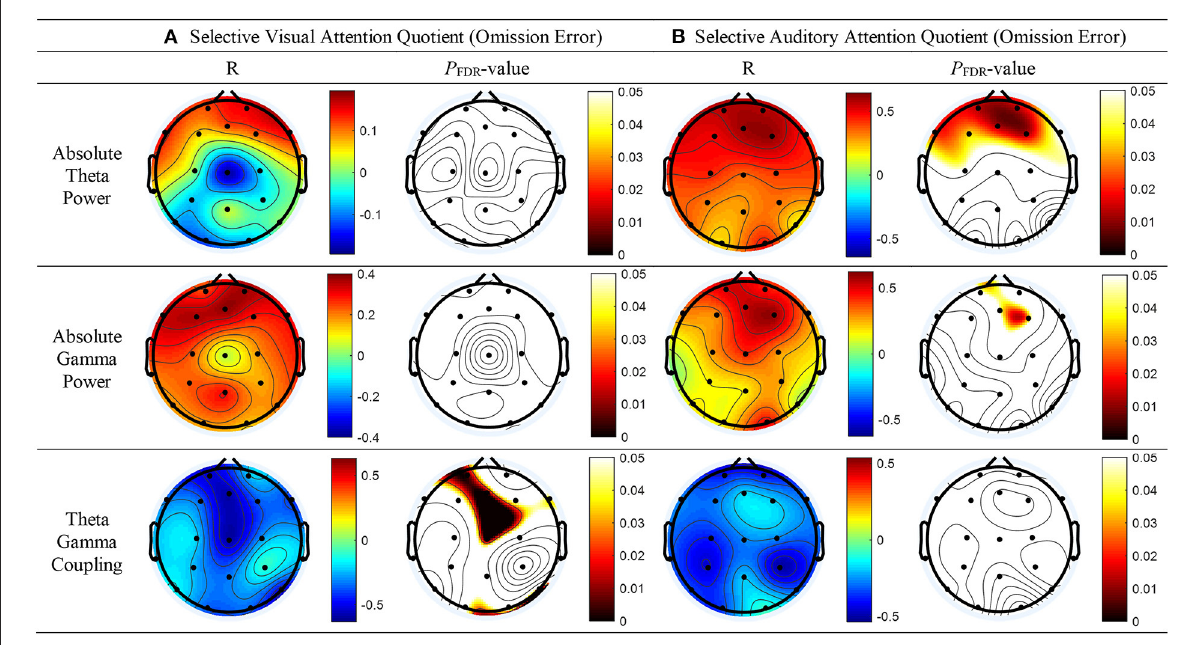
FIGURE2 Topographical representation of the results of the Pearson’s correlation analysis conducted to determine whether absolute theta power, absolute gamma power, and theta–gamma coupling are associated with the attention quotients (AQs) of omission errors (OEs) for selective attention in patients with tic disorder and healthy children. (A) AQs of OEs for selective visual attention (left panel: Pearson’s correlation coefficients, right panel: false discovery rate–corrected p -values). (B) AQs of OEs for selective auditory attention (left panel: Pearson’s correlation coefficients, right panel: false discovery rate–corrected p -values).